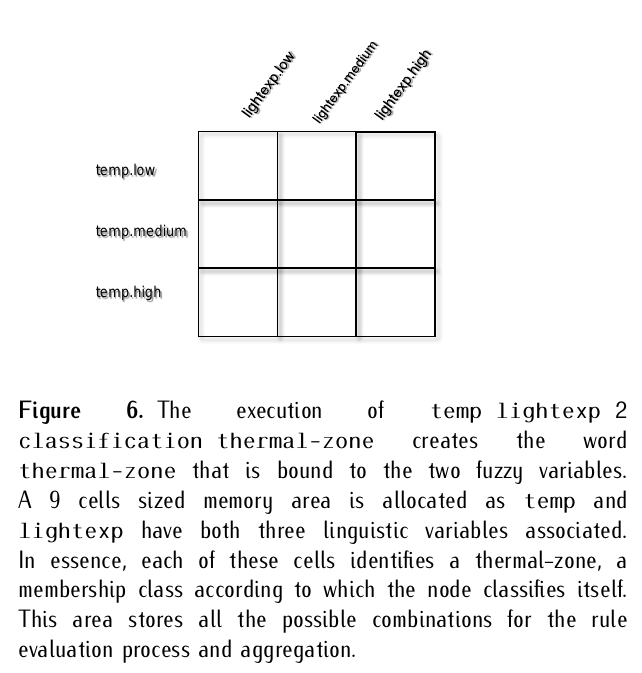
fval fie d. Basicall y this word scans the linked list and fuzzifie